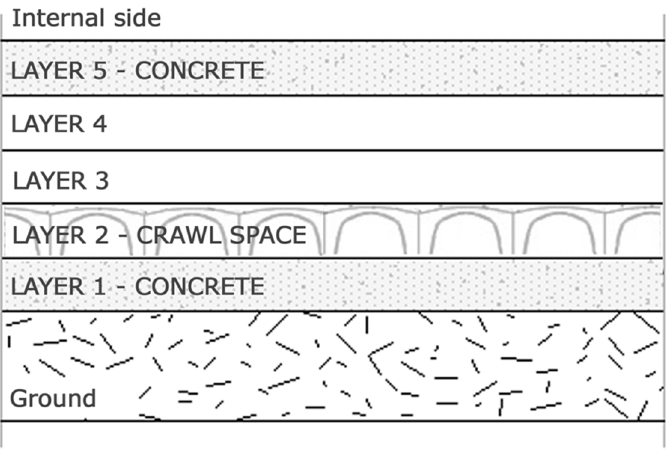
Figure 7. Case 3: Stratification of the slab-on-ground floor with air.